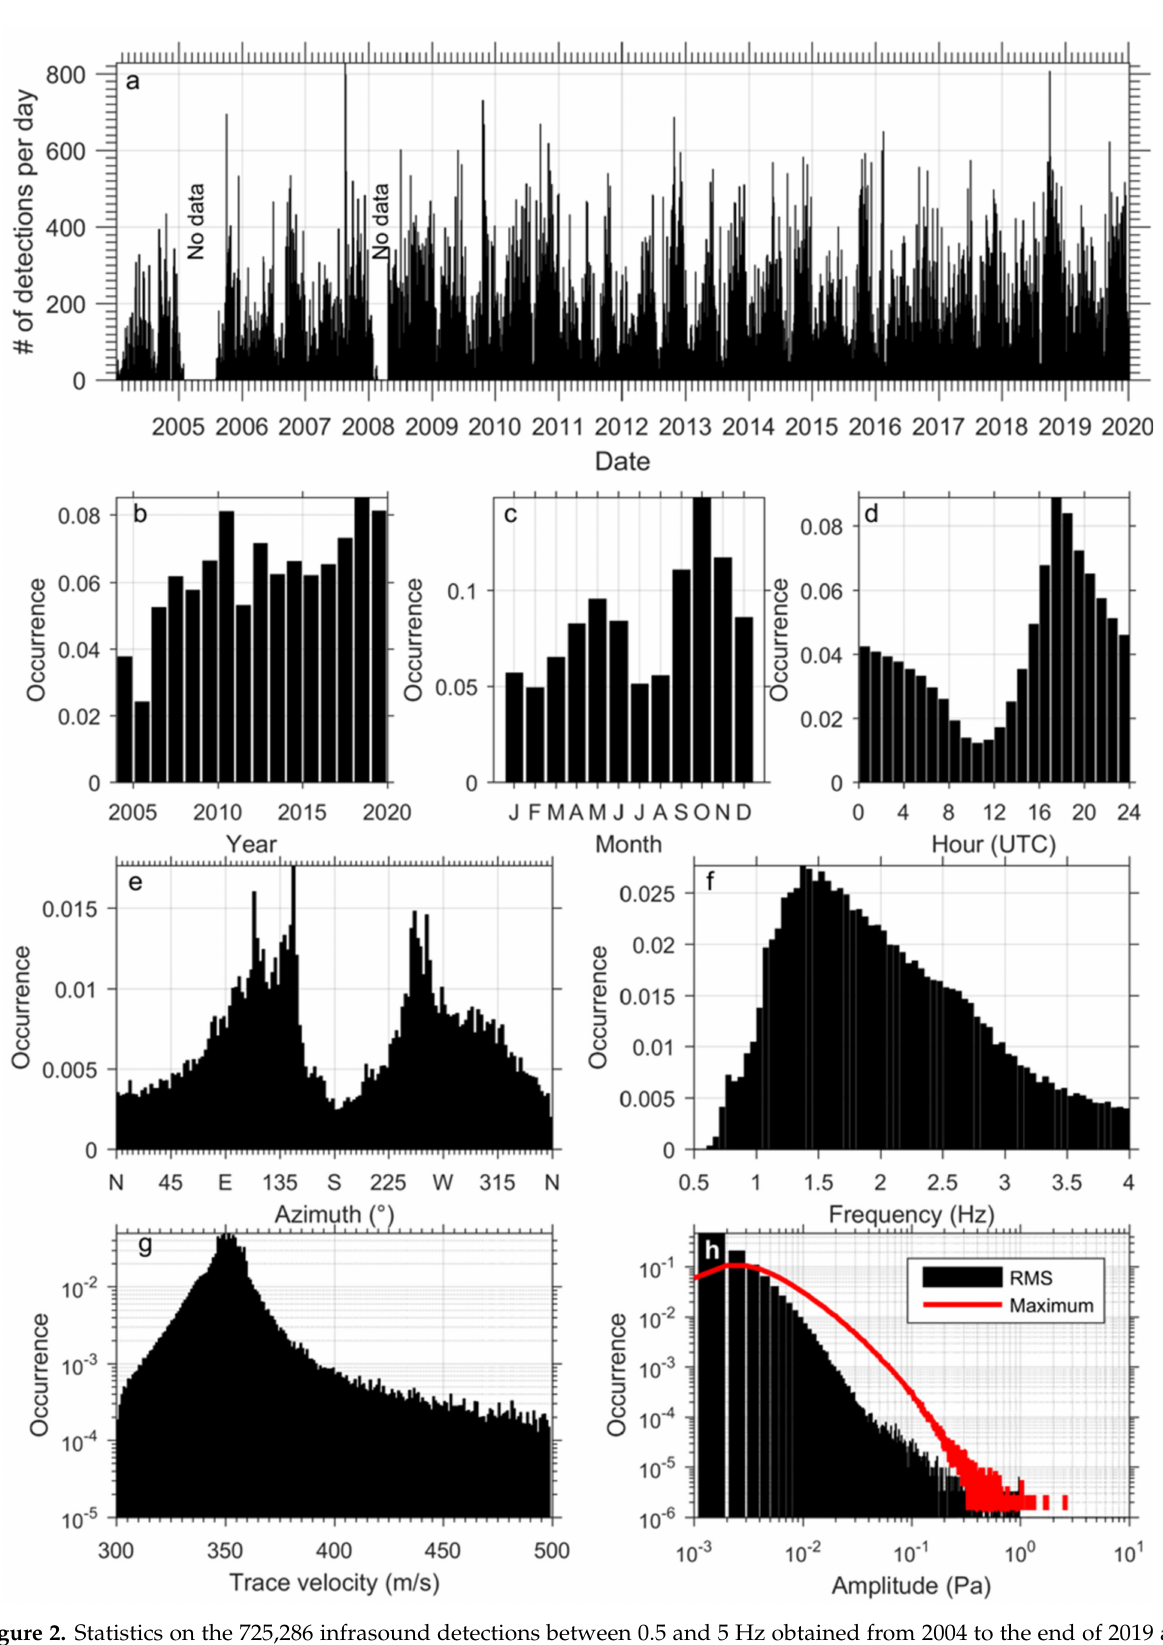
Figure 2. Statistics on the 725,286 infrasound detections between 0.5 and 5 Hz obtained from 2004 to the end of 2019 at IS17. Temporal distributions are given for daily ( a ), yearly ( b ), monthly ( c ), and hourly ( d ) variations. The distribution of wave-front parameters is given for azimuth ( e ), center frequency ( f ), trace velocity ( g ), and amplitude, both RMS and maximum ( h